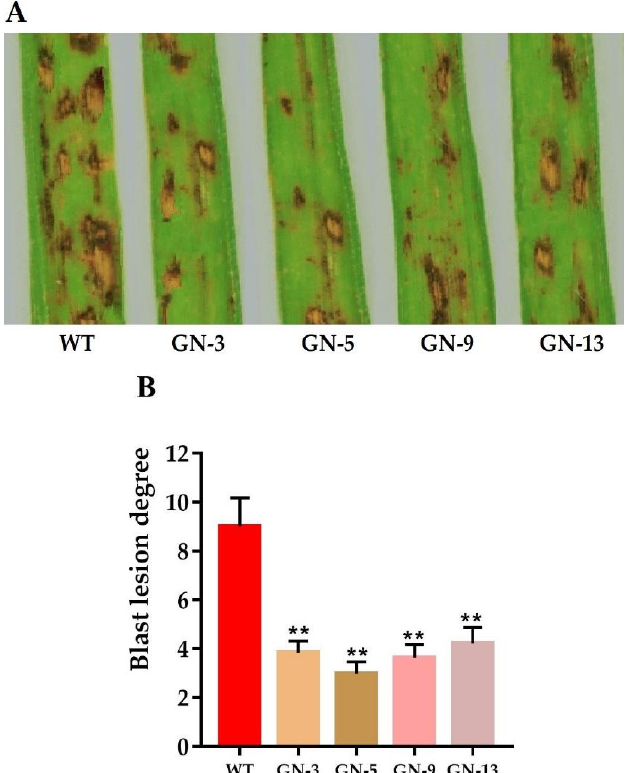
Figure 2. Phenotypic appearance of wild-type and mutant lines inoculated with M. oryzae ( A ) after 5 dpi and ( B ) Blast disease scoring in WT and mutant plants “**” denotes the significant difference, student’s t -test, P ≤ 0.01, n = 10.